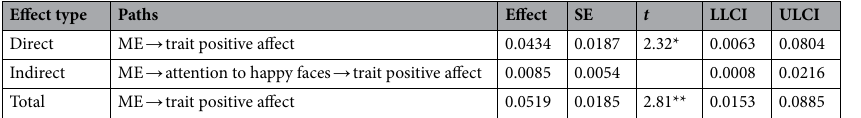
Table 3. Mediation model for the effect of managing emotion (self) on trait positive affect (PANAS) via attention to happy faces (dwell time on happy faces). ME, managing emotion (self); SE, standard error; LLCI, lower limit confidence interval; ULCI, upper limit confidence interval * p < 0.05, ** p < 0.01.